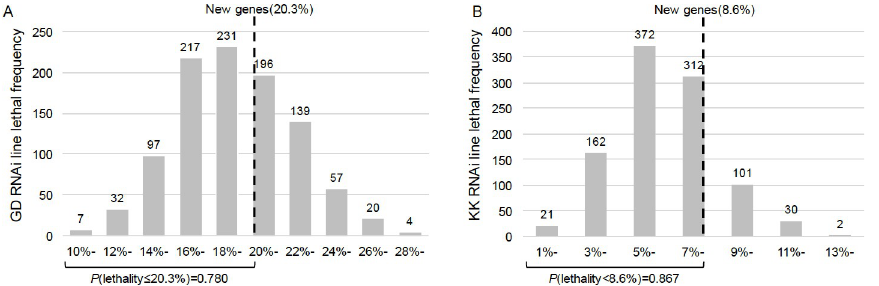
Fig 4. Comparison of proportions of lethality between new genes and old genes in GD lines (A) and KK lines (B) suggests that in both GD and KK lines, new genes have an equally high probability to be lethal as old genes. By using the essentiality data of 10,652 old genes provided by VDRC (https://stockcenter.vdrc.at/control/library_rnai) that were in branch 0 [15], we characterized the statistical distribution of essential old genes. Since old genes are much more abundant than new genes, we independently sampled 1000 times of old genes with the same number (150) of new genes and then plotted the distribution of proportion of essential genes as histograms. In the GD library, the probability to obtain a proportion of essential new genes equal or lower than 20.3% is 0.780. Meanwhile, in the KK library, the probability to observe a proportion of essential new genes equal or lower than 8.6% is 0.867. These analyses of GD and KK libraries reveal similarly that the proportions of new and old genes with lethal phenotypes are not statistically